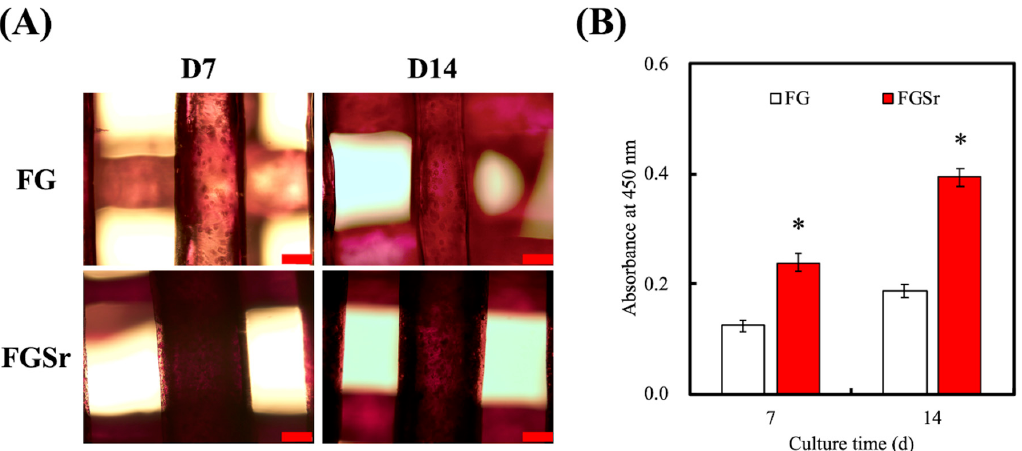
Figure 11. ( A ) Alizarin Red S staining and ( B ) quantification of calcium mineral by WJMSC-laden scaffolds. Scale bar: 200 μ m. “*” indicates a significant difference ( p < 0.05) when compared to FG scaffold. Data presented as mean ± SEM, n = 3 for each group.